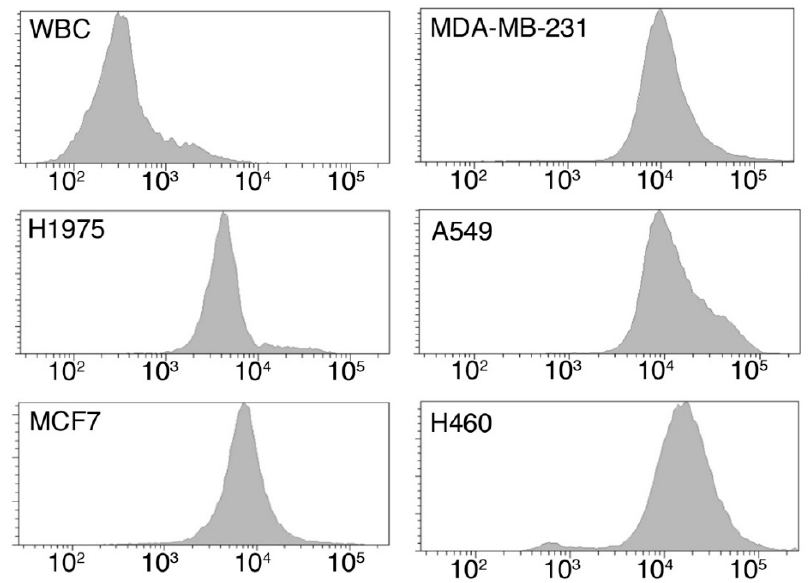
Figure 1. Measurement of glucose uptake by flow cytometry. Representative histograms reporting the 2-NBDG fluorescence of WBCs and of the tested cell lines H1975, MDA-MB-231, MCF7, A549, and H460. Table 1. Uptake of glucose analogue by different cell types. The 2-NBDG uptake is expressed as mean fluorescence intensity and standard deviation (SD). Each cell line and WBC from three different healthy subjects were tested in triplicate. * p value obtained comparing cell lines and WBC by Mann– Whitney test.